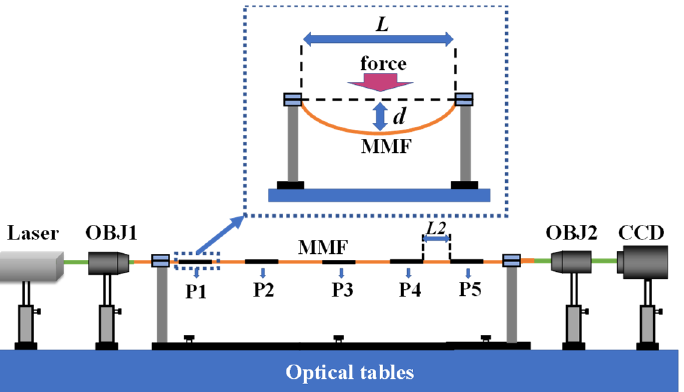
Figure 1. The architecture of classification neural network based on CNN.